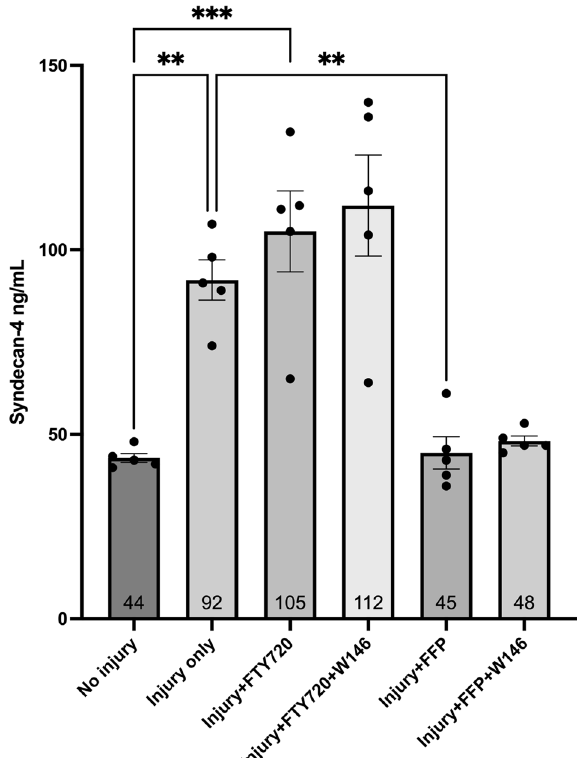
Fig. 2 Syndecan-4 (SDC-4) concentration in cell culture supernatant. The effect of treatment with FTY720 or fresh frozen plasma (FFP) with and without 10 µ M of the sphingosine 1-phosphate receptor 1 (S1PR 1 ) antagonist W146 on SDC-4 shedding from injured cultured human umbilical vein endothelial cells (HUVECs). ** p < 0.01, *** p < 0.001; N 5 for each =